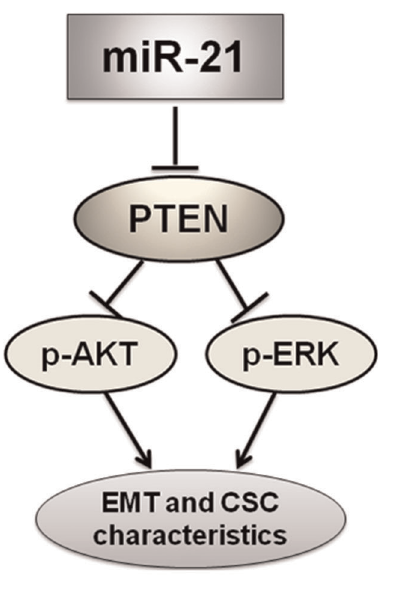
Figure 7. Schematic diagram of the proposed model: possible mechanism of miR-21 regulates EMT and CSC phenotype. Antagonism of miR-21 could inactivate AKT and ERK1/2 pathways presumably through PTEN up-regulation, and finally reverse EMT and CSC phenotype in MDA-MB-231 cells.